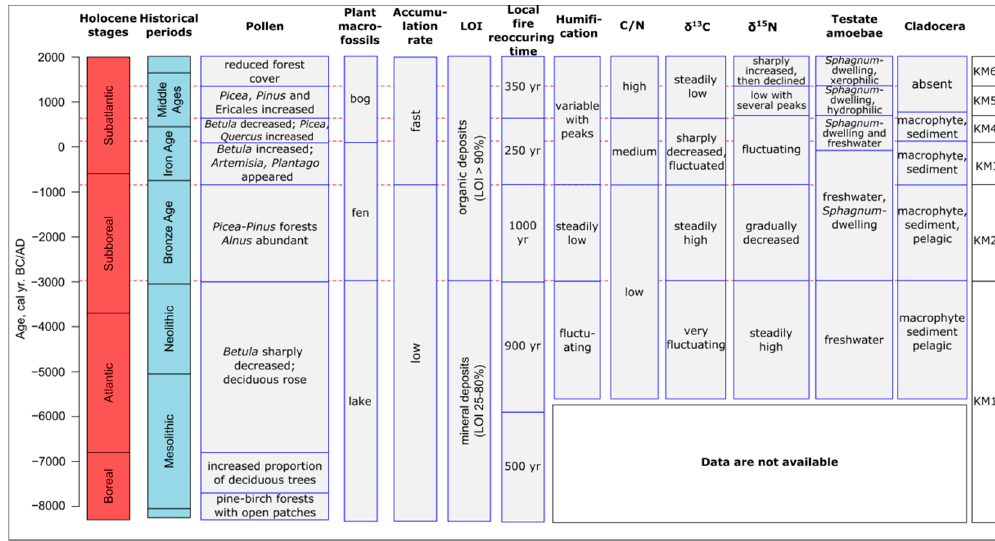
Figure 3. Main stages (KM1–KM6) of the mire development and environment dynamics. The dynamics of the proxies are described in comparison to the preceding period (i.e., lower zone). More details on the dynamics of particular taxa can be found in Figures 5–9.